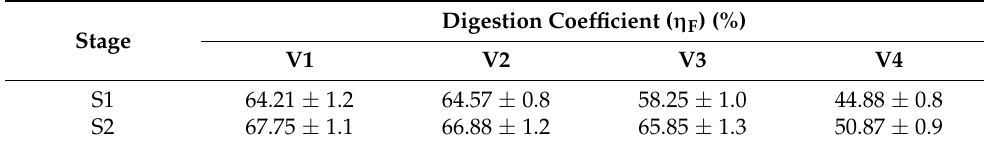
Table 3. Digestion coefficient across experimental variants.